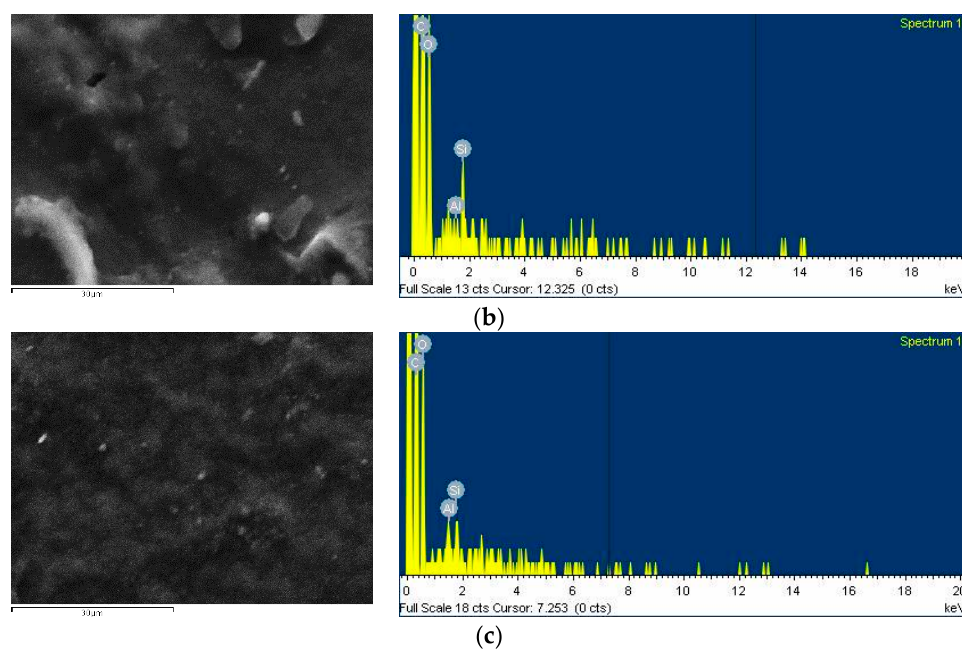
Figure 2. SEM micrographs and EDX spectra of ( a ) PPF/MMT, ( b ) PPF/MMT 20A, and ( c ) PPF/HNT nanocomposites. The scale bar in the micrographs is 30 μ m.